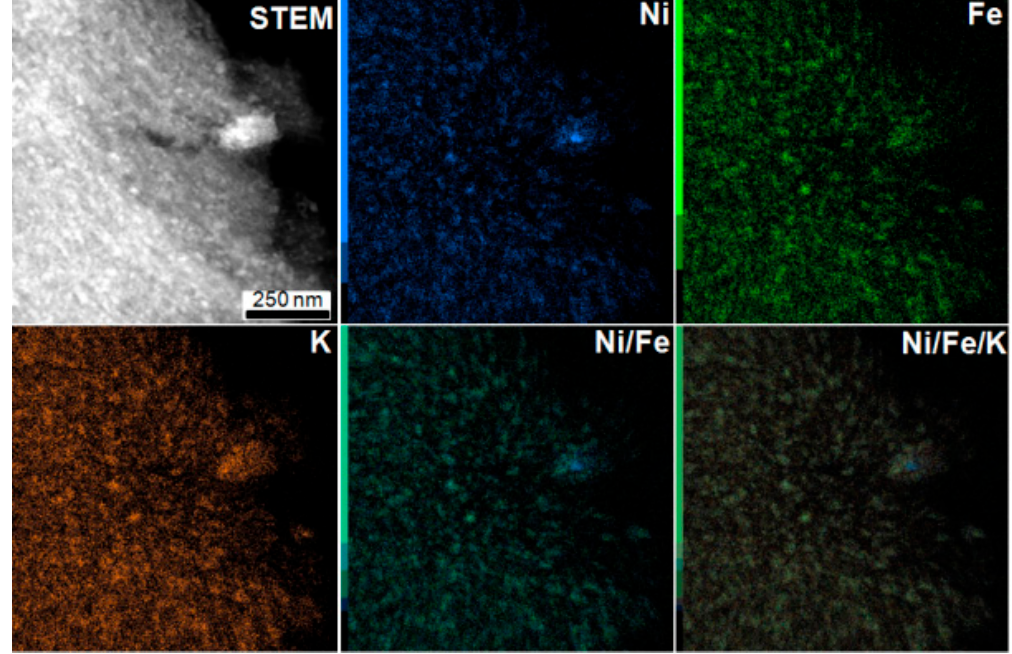
Figure 2. EDX mapping of the C/NiHCFe material showing the nickel, iron, and potassium presence in the nanoparticles. Superposition of Ni and Fe and Ni, Fe, and K mapping.